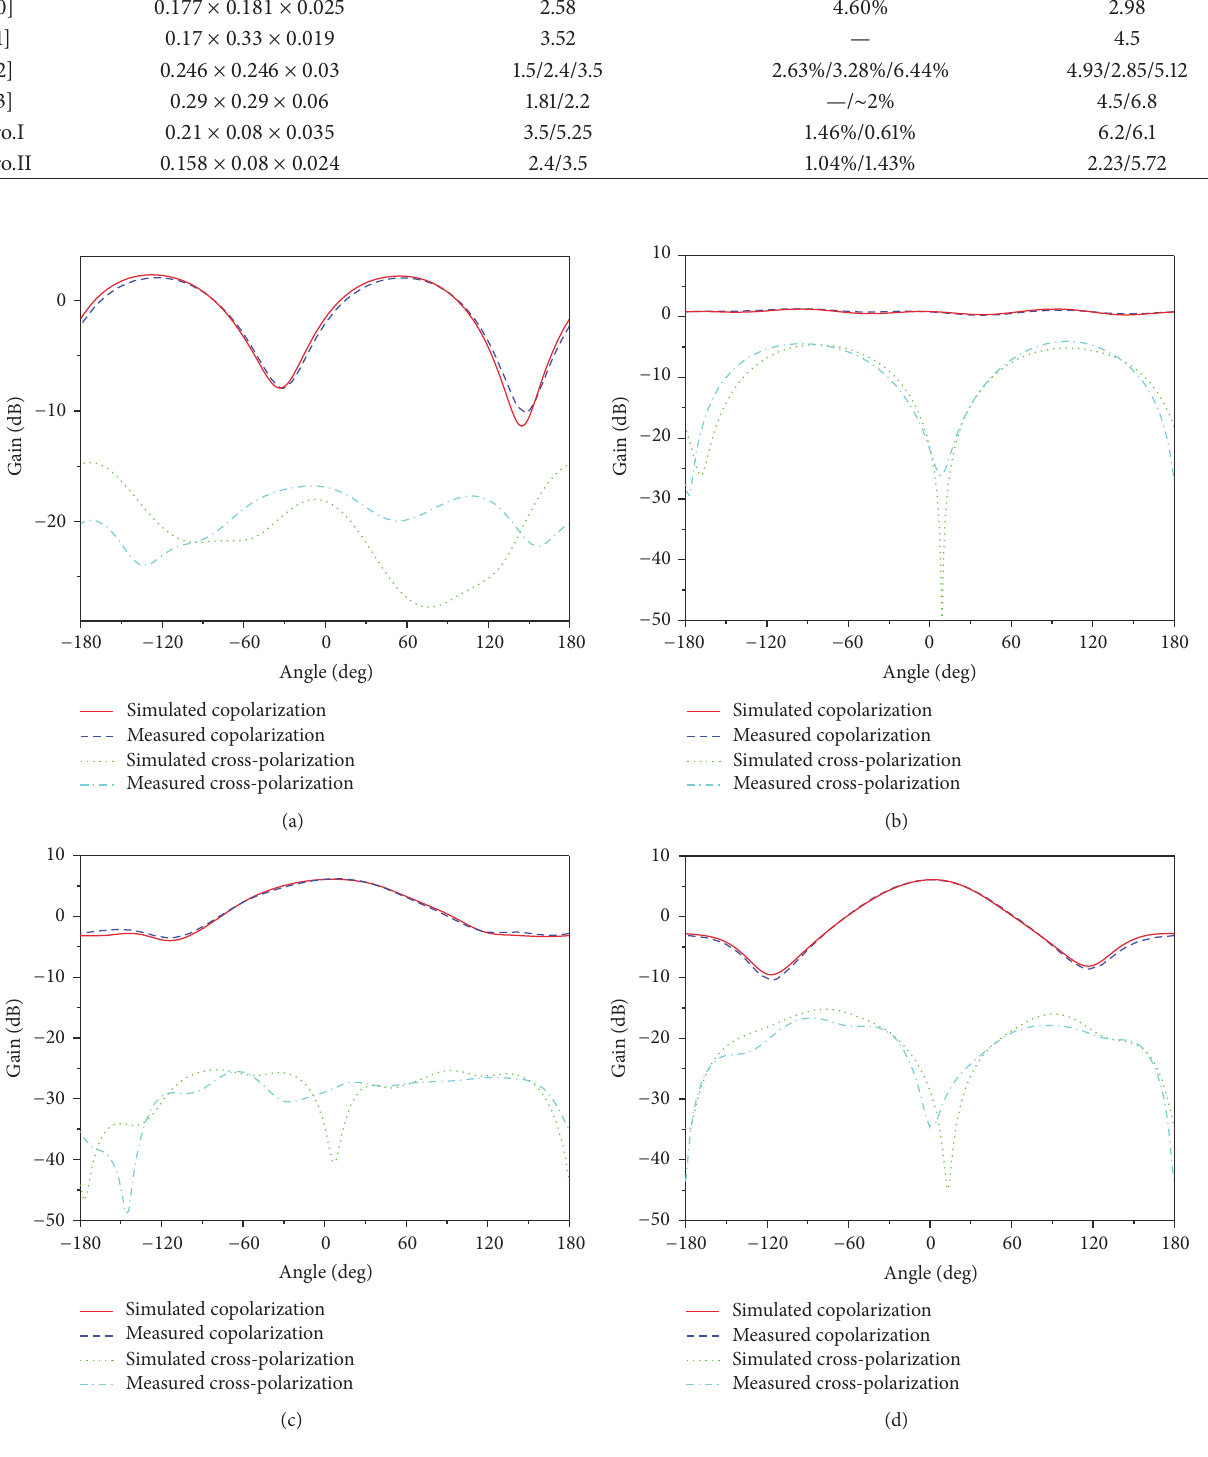
Figure 12: Radiation patterns of the proposed antenna. (a) E-plane at 2.4 GHz; (b) H-plane at 2.4 GHz; (c) E-plane at 3.5 GHz; (d) H-plane at 3.5